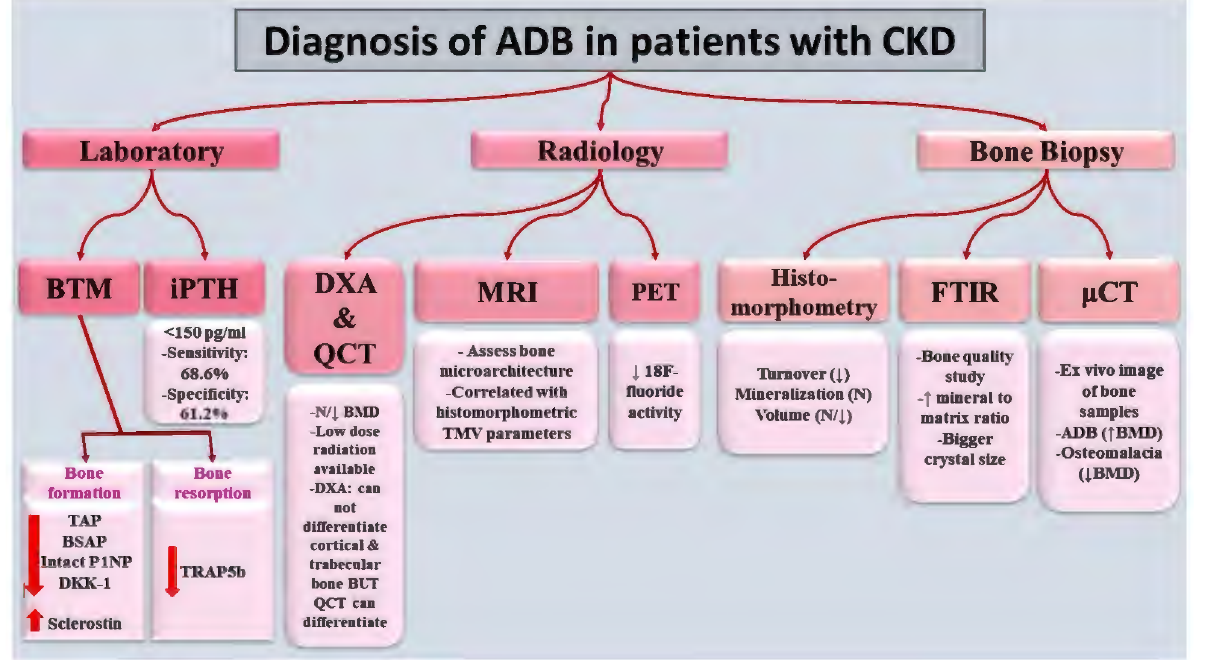
Figure 2. Diagnosis of ADB in patients with CKD. Diagnosis mainly relies on bone biopsy, gold